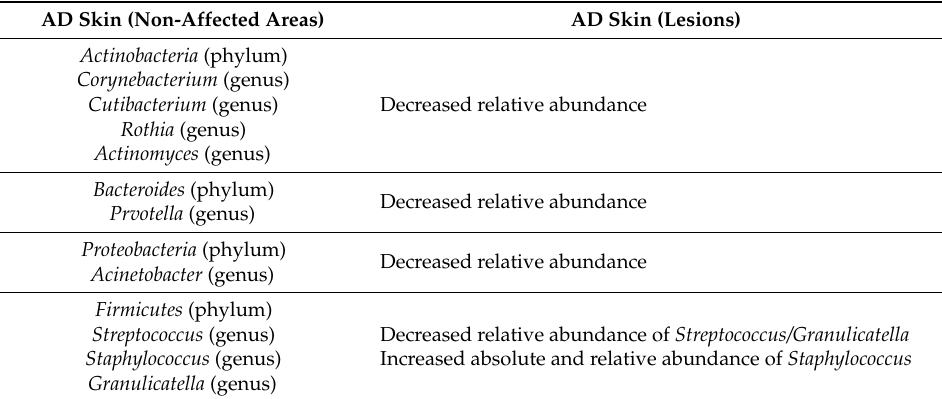
Table 2. Changes in microbial diversity in non-affected vs. lesional AD